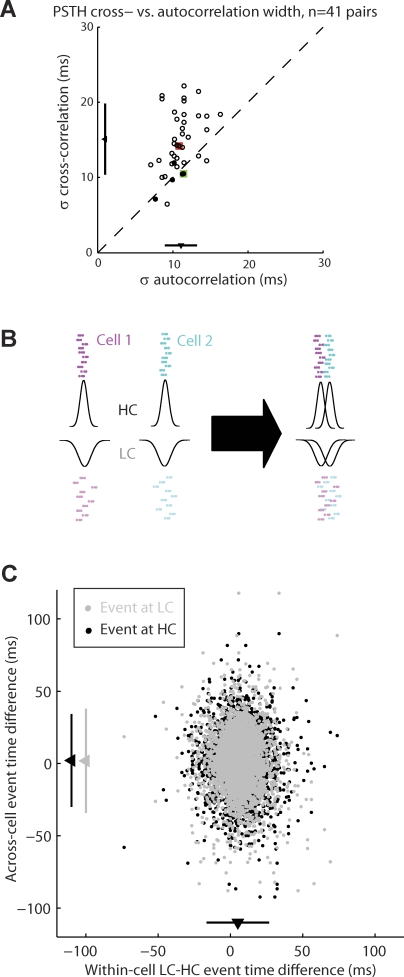
Spike Timing Precision across Cells Is Insensitive to Contrast Despite Contrast Effects on Single-Cell Event Timing(A) Temporal width of the PSTH cross-correlation of cell pairs as a function of the larger temporal width of the PSTH autocorrelations of both cells in each pair at HC. Black dots correspond to pairs sharing common retinal input and colored dots correspond to the two example pairs from Figure 4A and 4B.(B) Spike timing precision across cells is insensitive to the global level of contrast (see main text).(C) Full distribution of event time differences in all pairwise events (n = 4,205). The abscissa corresponds to the single-cell, contrast-based event time difference. The ordinate corresponds to the across-cell event time difference, both at HC (black) and at LC (gray). The mean ± 2 standard deviations are represented along each axis by an arrowhead and bar.